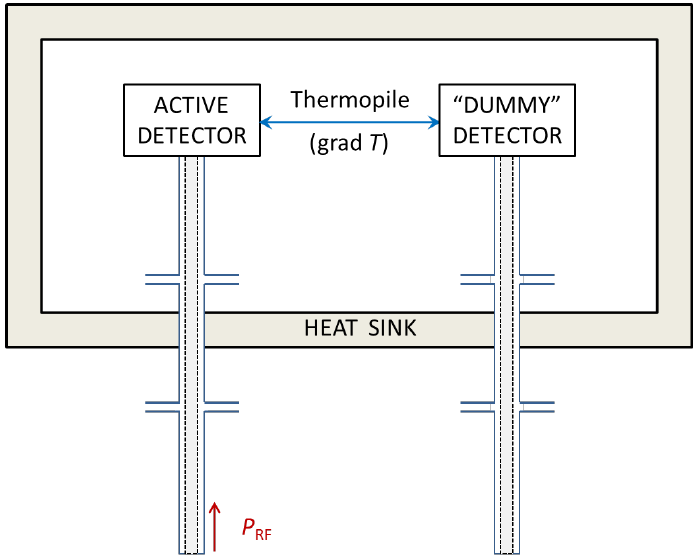
Figure 1. Proposed use of the adiabatic coaxial line with two gaps in microcalorimeter.